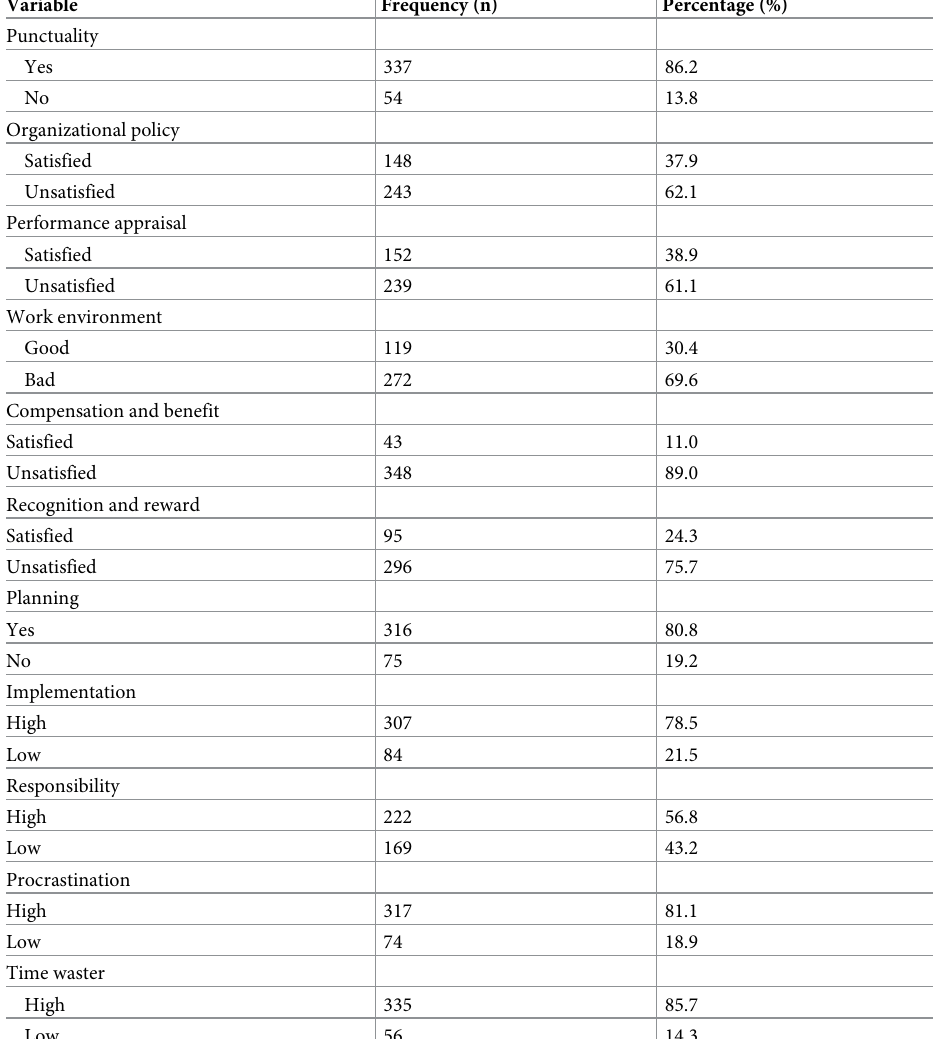
Table 2. Organizational policy, employee’s performance and personal related factors of respondents in North Gondar, Ethiopia, 2017 (n =